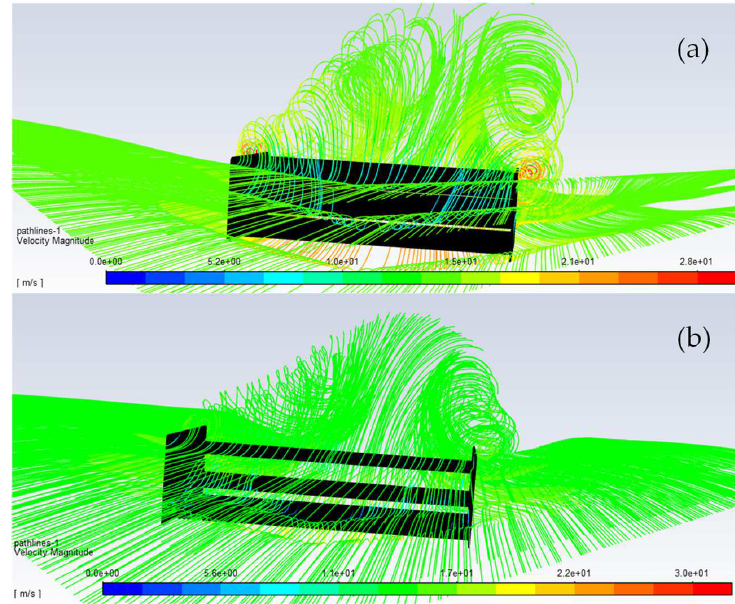
Figure 11. Pathlines: ( a ) closed DRS; ( b ) open DRS.